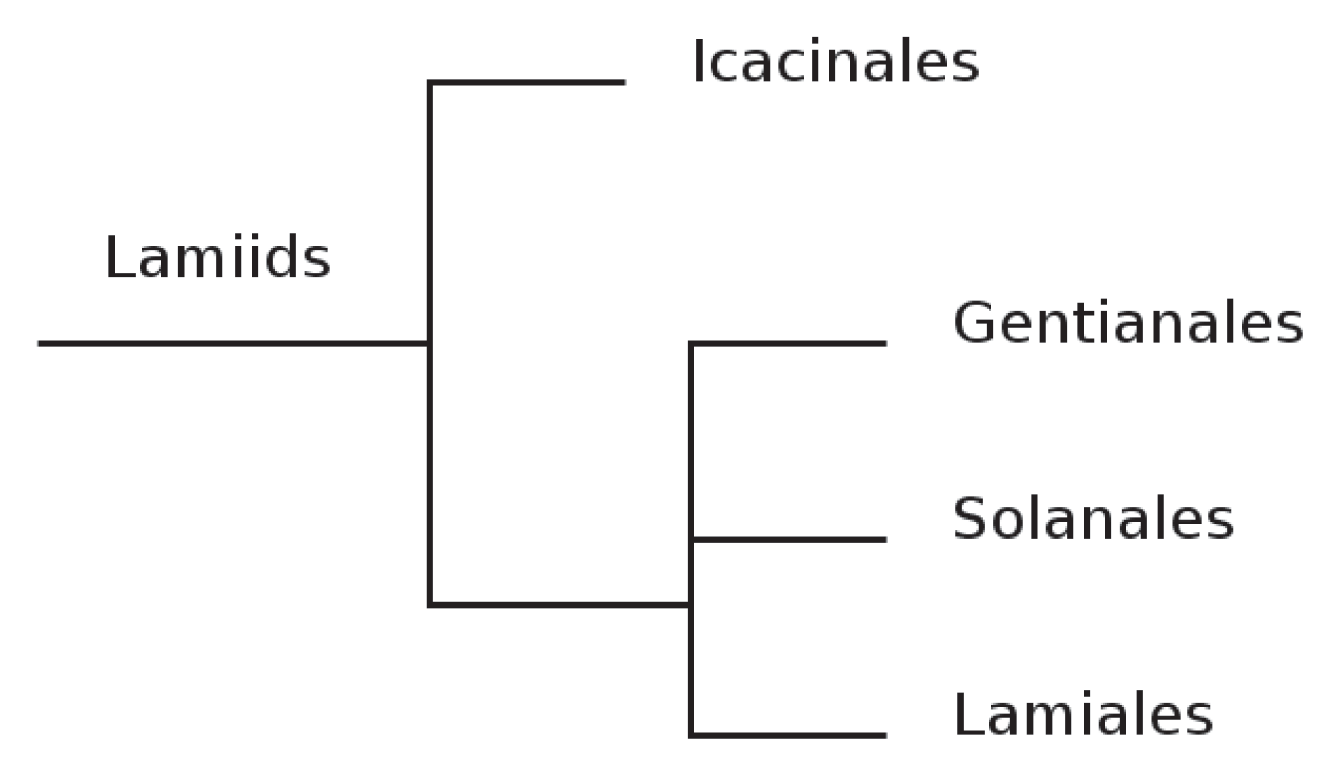
Fig 7. Gentianales and its neighboring orders phylogenetic relationships. The tree is based on the taxonomy and data available on the NCBI website.